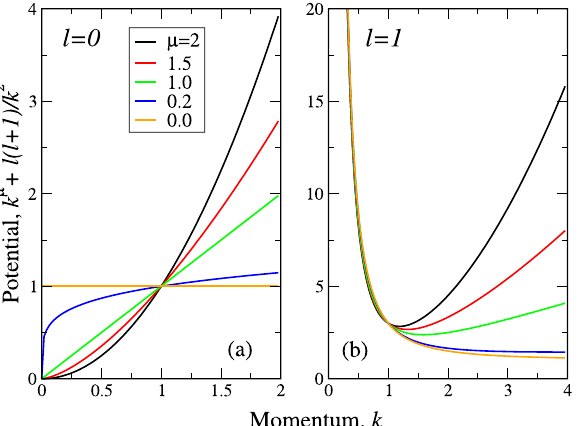
0 ( a ) and l 1 ( b ). Lévy indices µ are coded by colors = =